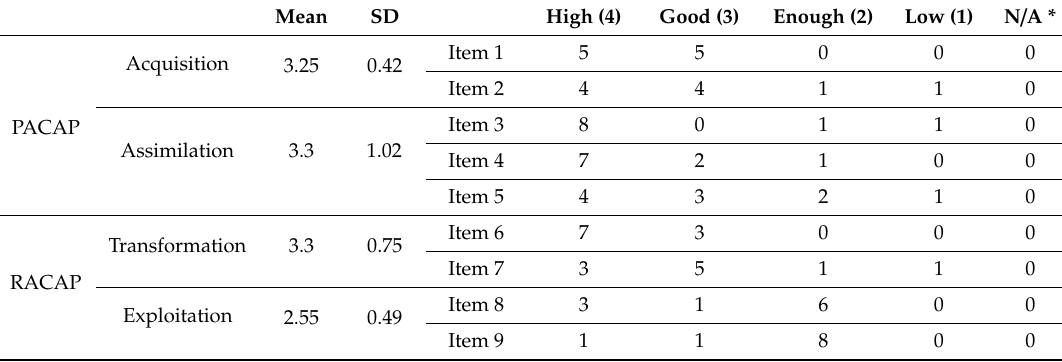
Table 2. Descriptive statistics and grouped frequency of answers separated by degree of ACAP (N = 10). Mean